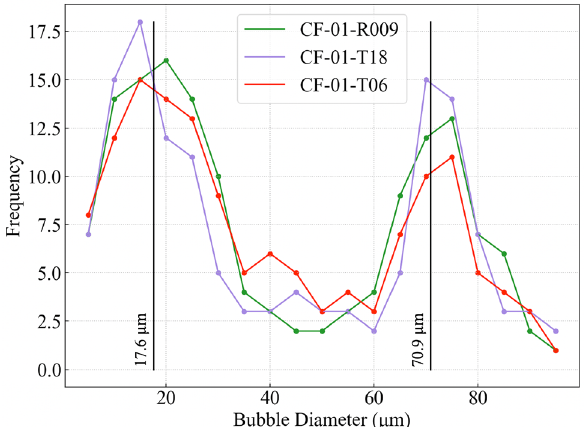
Figure 4. Plot of void diameter against frequency demonstrating the bi-modal void size distribution within ‘Type B’ CsMP. The first peak, located at 17.6 μm, represents the incorporated fission product bubbles, ‘frozen’ around the particle circumference due to quench-like cooling. The second peak, centred at 70.9 μm, shows the increased diameter of the gaseous voids as a result of depressurisation and coalescence. Adapted from 21